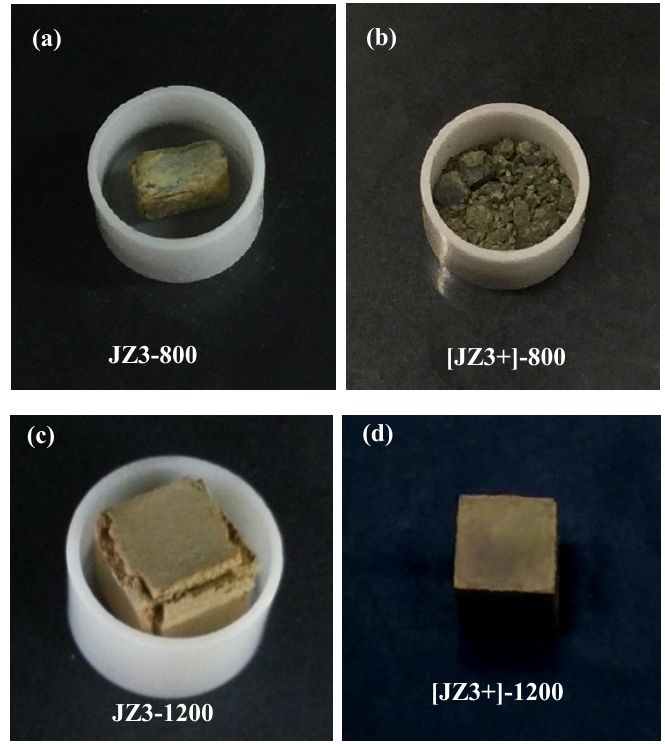
Figure 8. The specimens of the alloys JZ3 ( a , c ) and JZ3+ ( b , d ) after isothermal oxidation at 800 °C ( a , b ) and 1200 °C ( c , d ). Table 3. Weight gains and linear (k l ) and parabolic (k p ) oxidation rate constants of the alloys JZ3 and JZ3+ after isothermal oxidation at 800 and 1200 °C for 100 h.